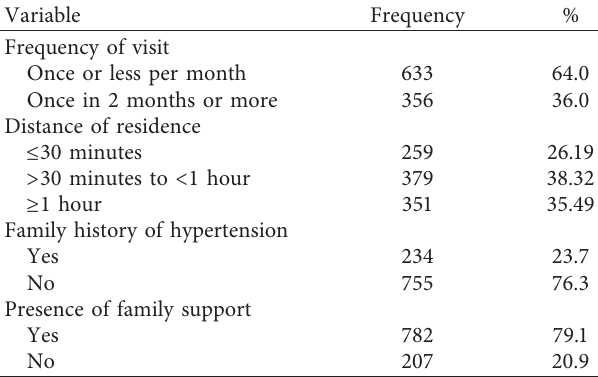
Table 2: Health-seeking and illness-related factors of hypertensive patients in Central Ethiopia, 2017 ( n �